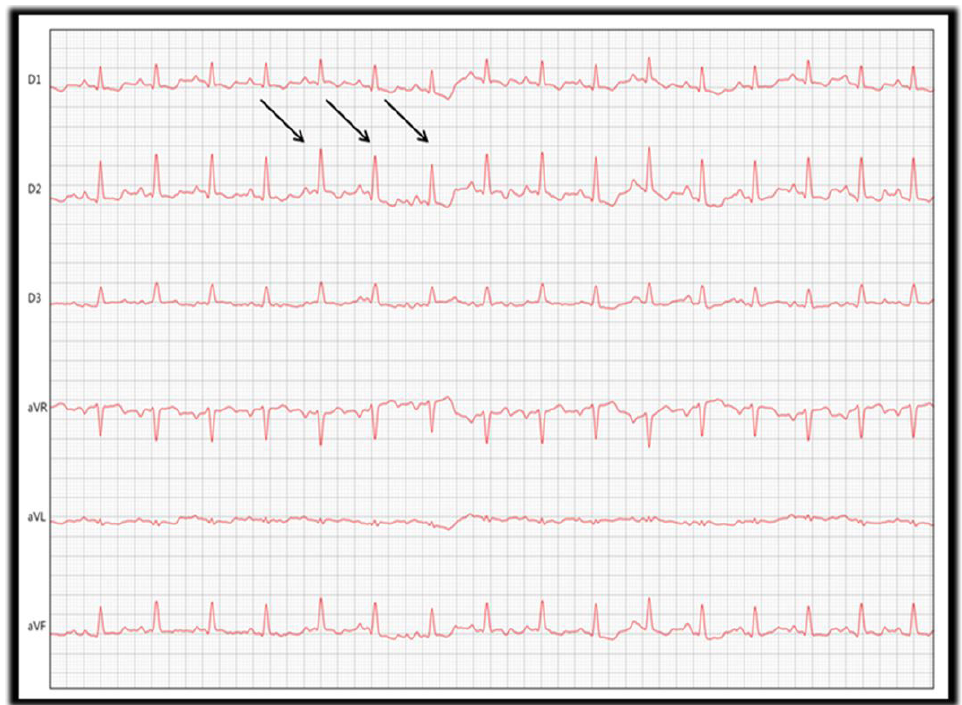
Figure 13. Electrocardiographic tracing at a speed of 50mm/s, showing tracing on bipolar leads, showing sinus rhythm, represented by regular R-R intervals (arrows). (Source: Personal